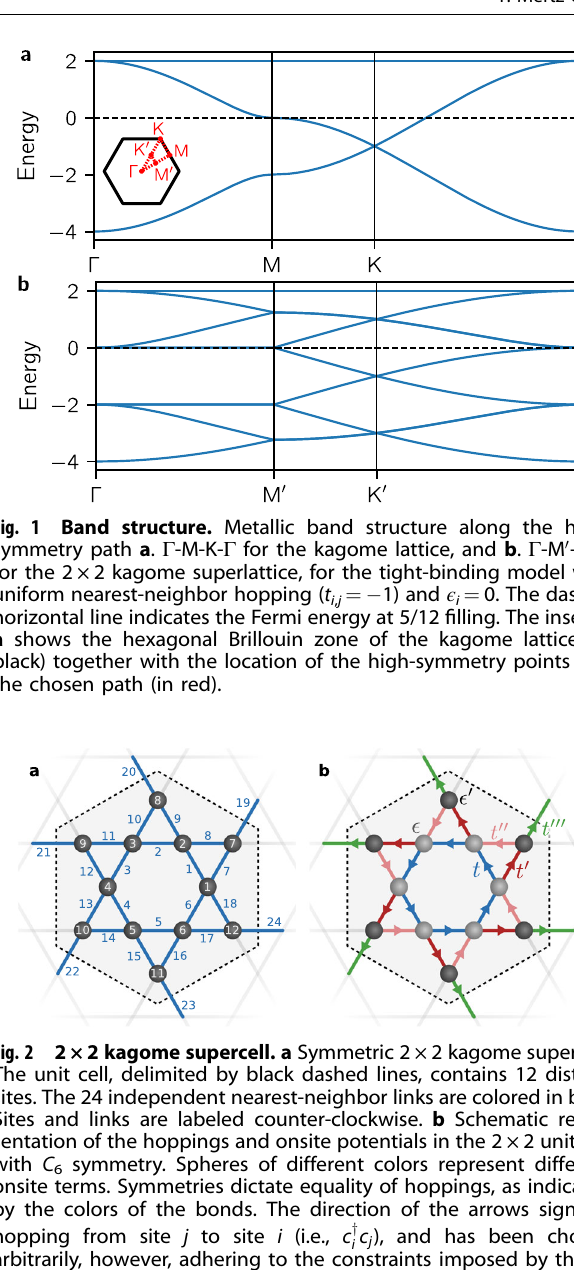
Figure 1. First, we analyze the PDF of the onsite term ϵ 0 ¼ ϵ i (cid:2) 7 (Fig. 3a) that distinguishes between trivial (grey line) and topological phases (colored lines). For the trivial phase, ϵ 0 tends to be larger than zero, i.e., the outer ring of the spikes tend to be